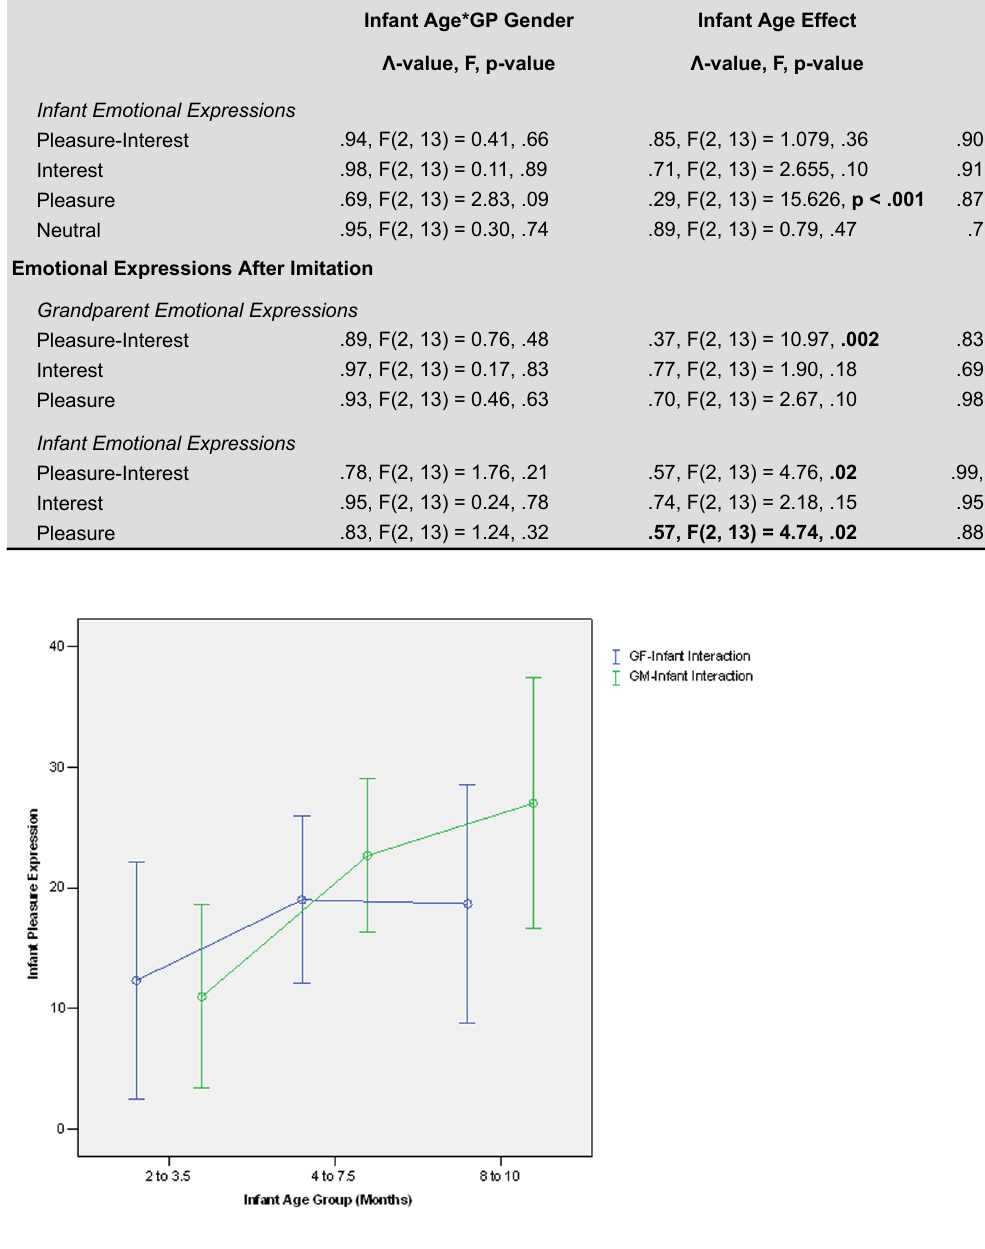
Figure 2. Developmental curves of infant pleasure expression (frequency) in dyadic grandfather and grandmother-infant grandchild interaction across the 2nd to the 10th month of an infant’s